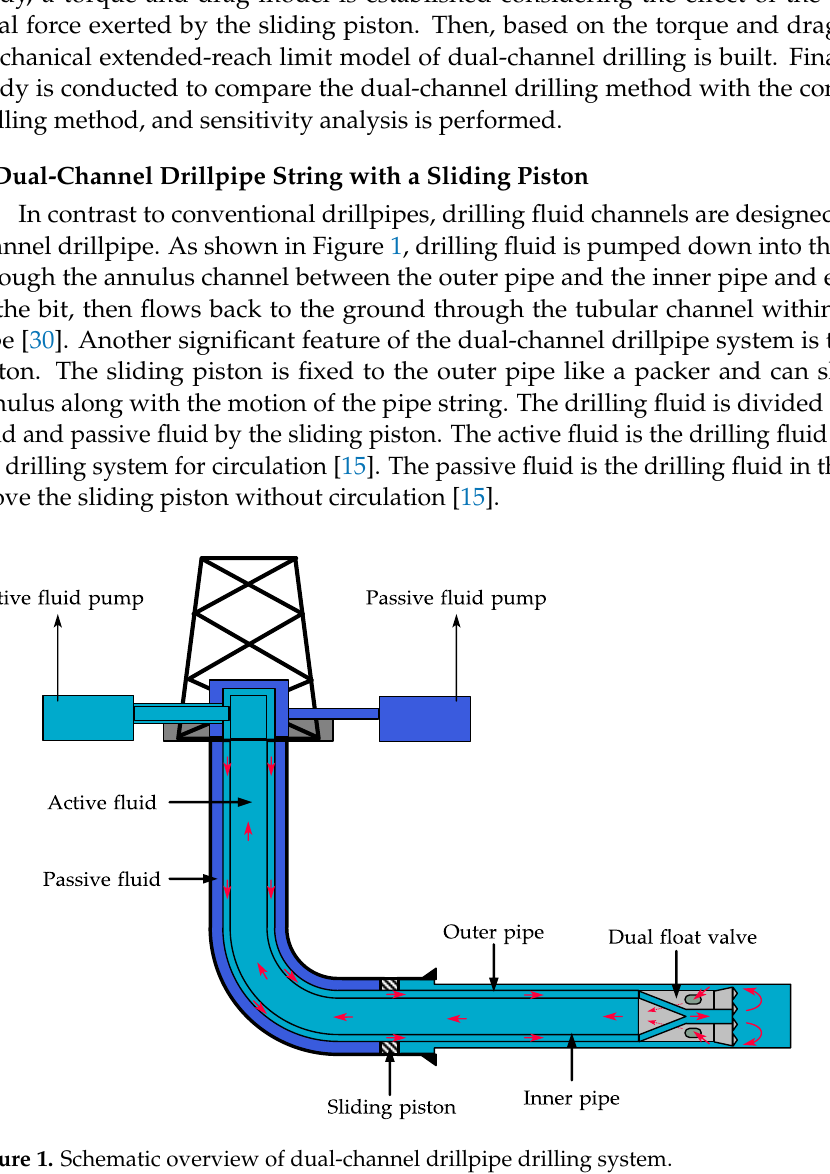
Figure 1. Schematic overview of dual-channel drillpipe drilling system.